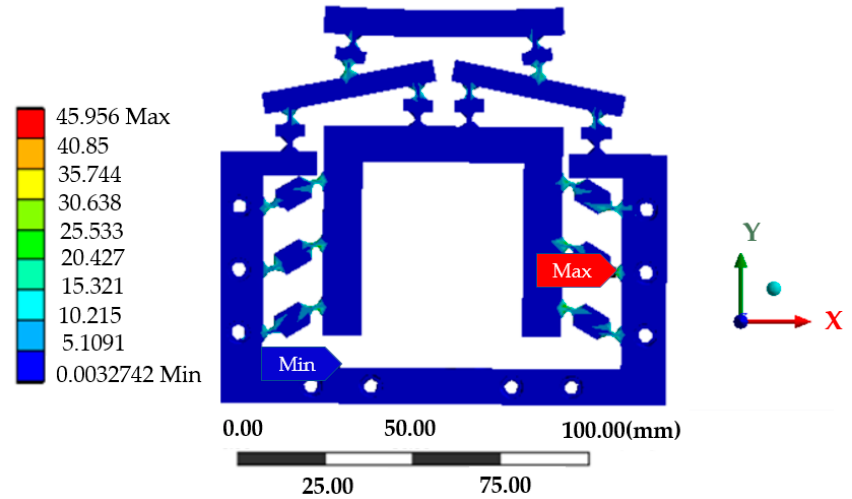
Figure 10. Stress cloud of the micro-drive mechanism.